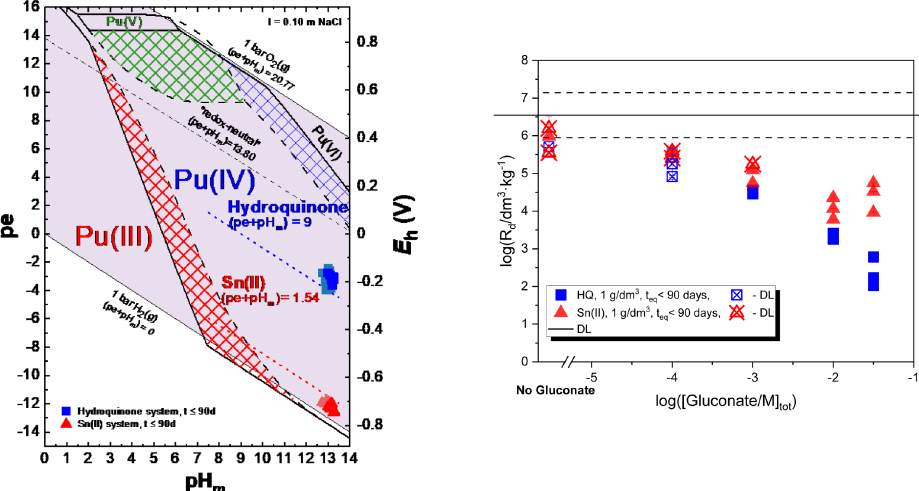
Fig. 8. Left: experimental (pe + pH m ) values determined for the Pu samples containing hydroquinone (HQ, blue symbols) or Sn(II) (red symbols) as redox buffers. Right: R d values determined for the uptake of Pu by C–S–H 1.4 in the absence and presence of gluconate at pH = 13.3. All experiments performed at S:L = 1 g dm − 3 . DL stands for detection limit (courtesy of R. Guidone et al. Empa (Switzerland) and KIT